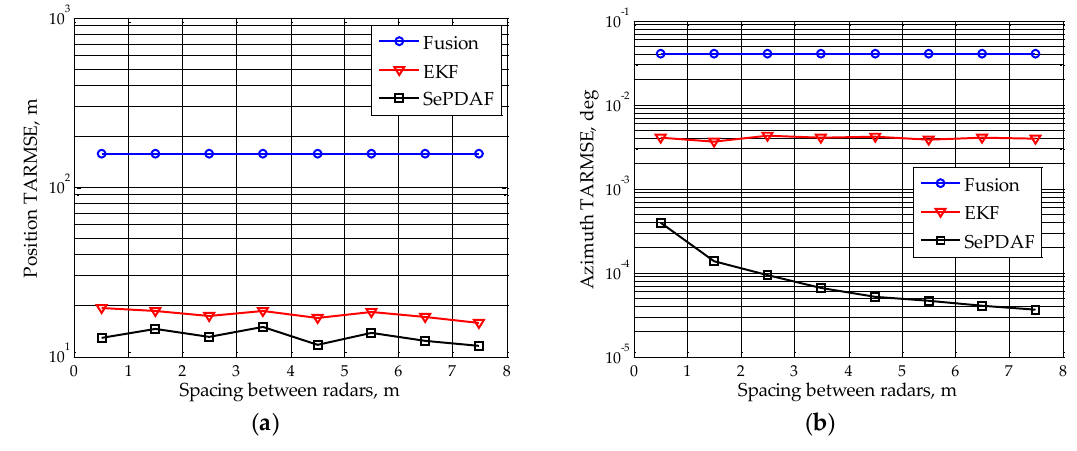
Figure 4. TARMSEs under different sub-radar spacing after using the proposed method: ( a ) position RMSE; and ( b ) azimuth RMSE.